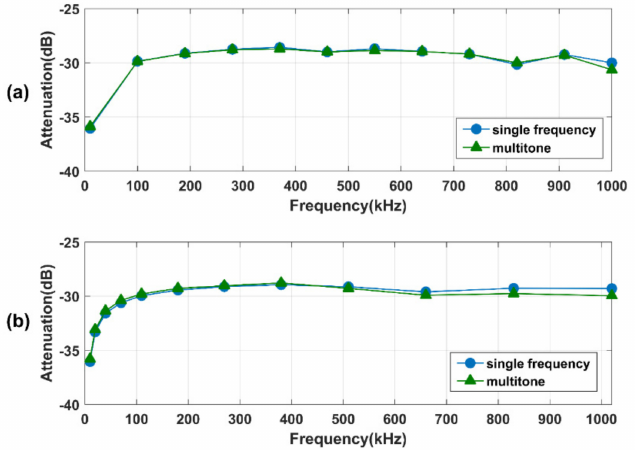
Figure 7. Results of the standard filter measurements using a spectrum analyzer (blue) and the system in this paper (red and orange), respectively.